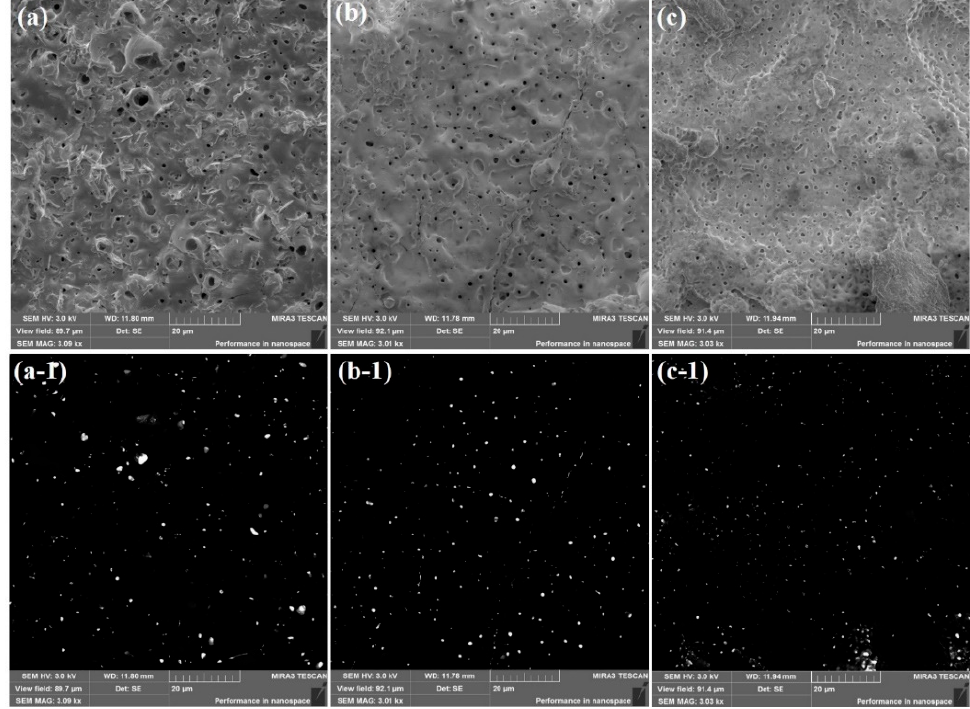
Figure 4. Surface morphology of PEO coatings of various electrolytes: ( a ) H; ( b ) P; ( c ) S, and pore distribution of PEO coatings in various electrolytes: ( a-1 ) H; ( b-1 ) P; ( c-1 ) S, obtained using an image analyzer by Altami studio.